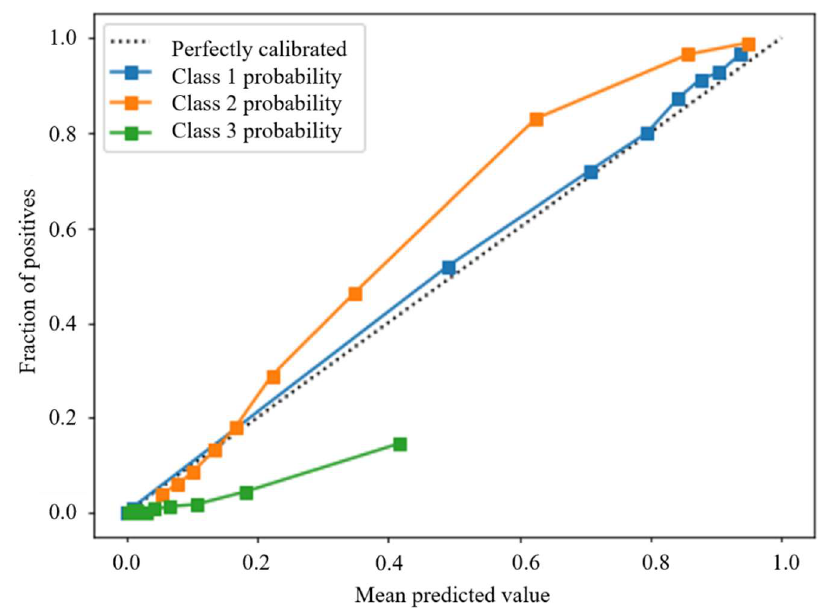
Figure 7. Probability plot of 3 classes before calibration.